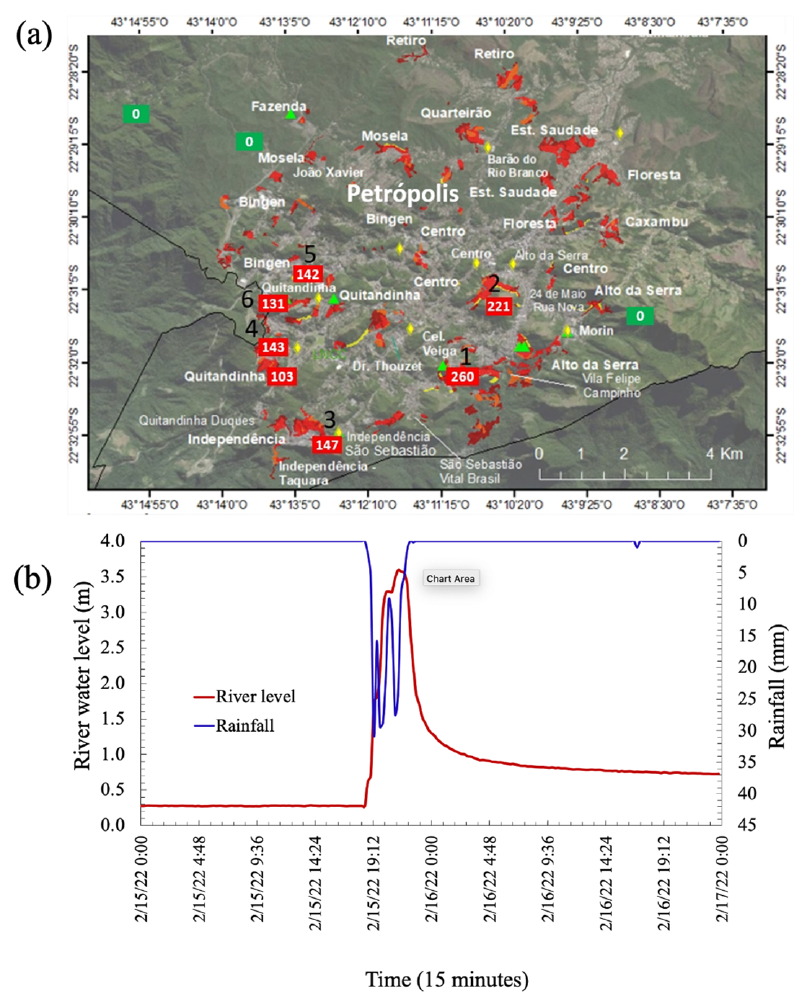
Figure 5. (a) Accumulated precipitation in 24h on 15 February 2022 at CEMADEN rain gauges. Red contours correspond to areas of risk for landslides at Petrópolis. The black line indicates the municipality limit. The cartographic base was obtained from © OpenStreetMap contributors 2022. Distributed under the Open Data Commons Open Database License (ODbL) v1.0. (b) Rainfall (blue) and river level (red) time series for 15 February 2022 time event, at Alto da Serra hydrological station